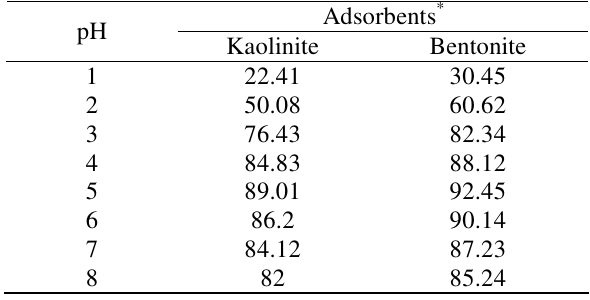
Table 2. Effect of pH on percent removal of